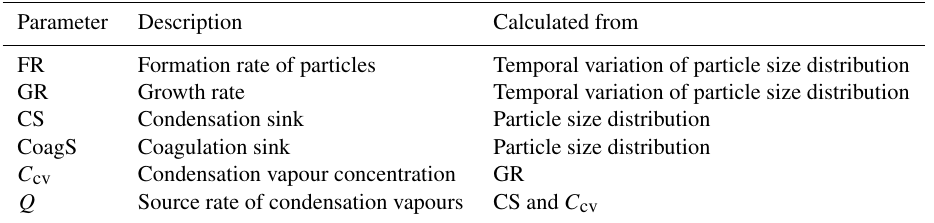
Table 1. Parameters to characterize NPF